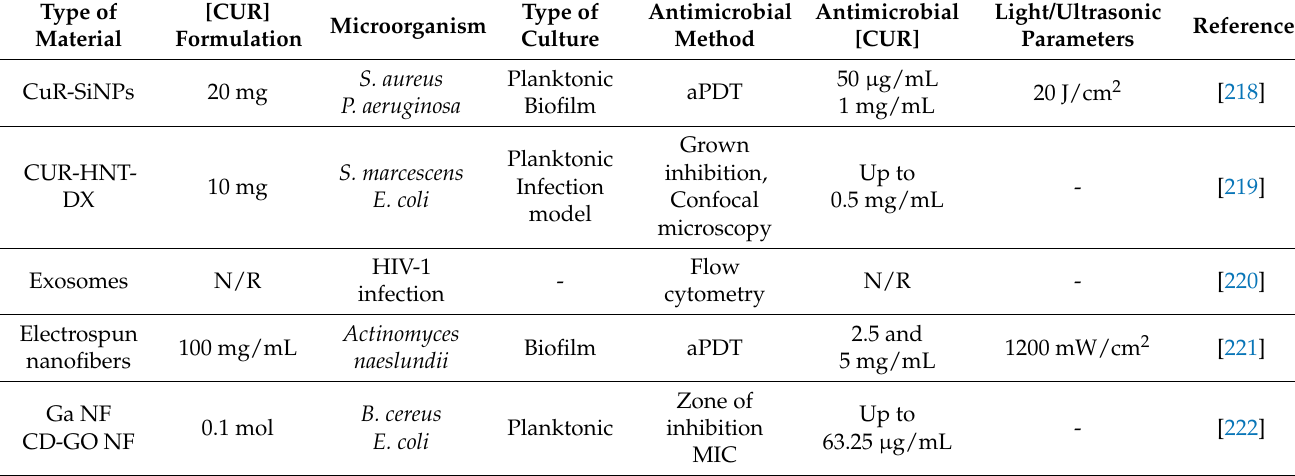
Table 11. Antimicrobial studies performed with CUR in films, hydrogels, and other